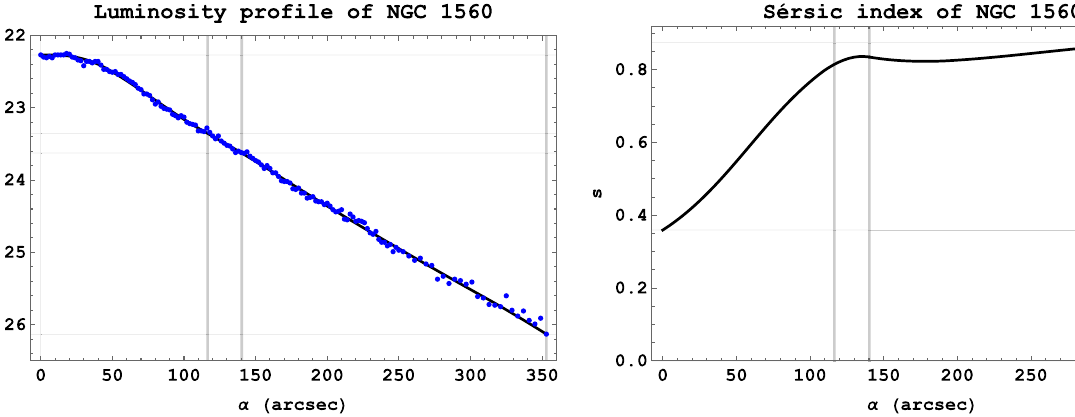
Fig. 3 The line in the left-hand side graphic shows the adjusted lumi- nosity profile of NGC 1560, and the dots correspond to the values listed by Broeils [32]. The right-hand side graphic shows the correspond- ing variable Sérsic index profile. The vertical lines in both graphics